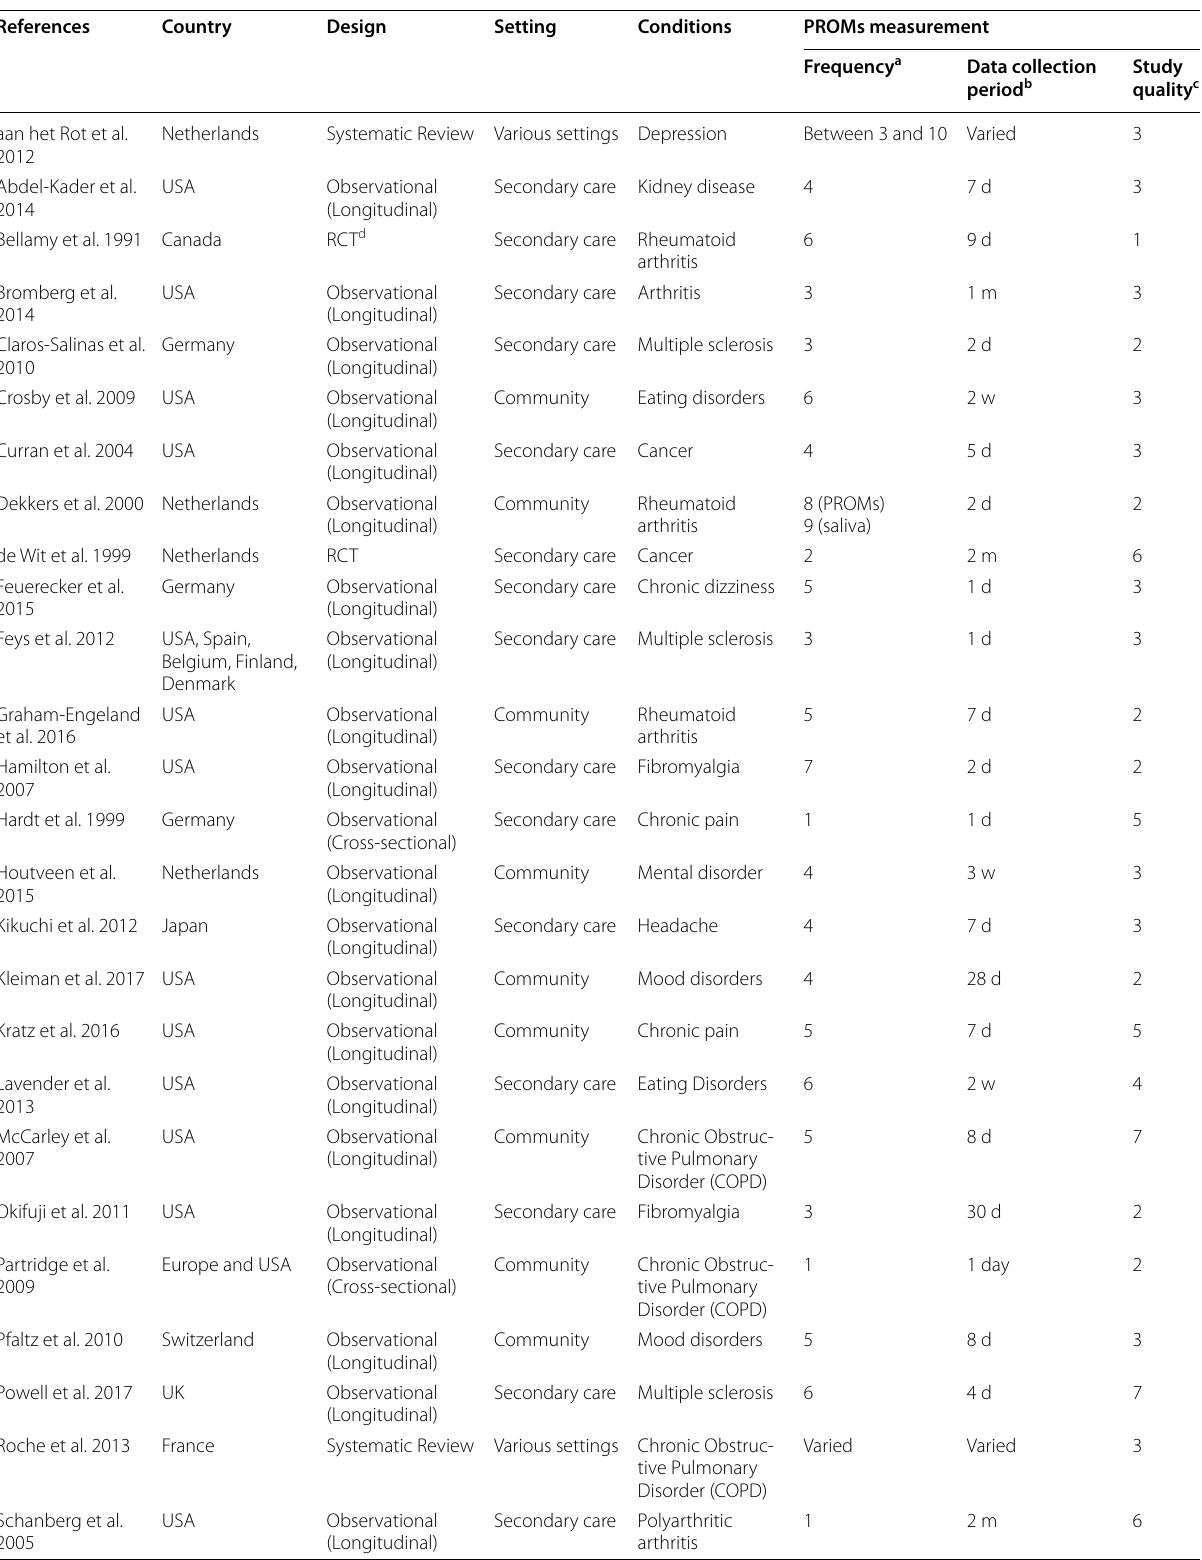
Table 1 Characteristics of the articles included in the